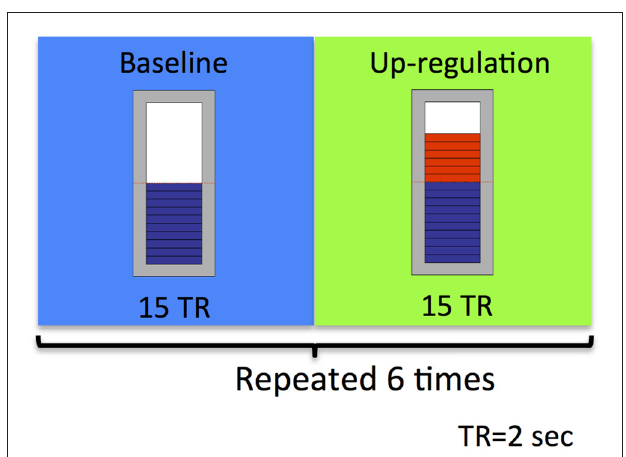
FIGURE 2 | Schematic illustration of the experimental neurofeedback paradigm used in our feasibility study. An rtfMRI-based neurofeedback training run consisted of alternating baseline and up-regulation blocks, repeated six times. Each block was 30 s long. left anterior insula, overlaid on an average EPI brain image.